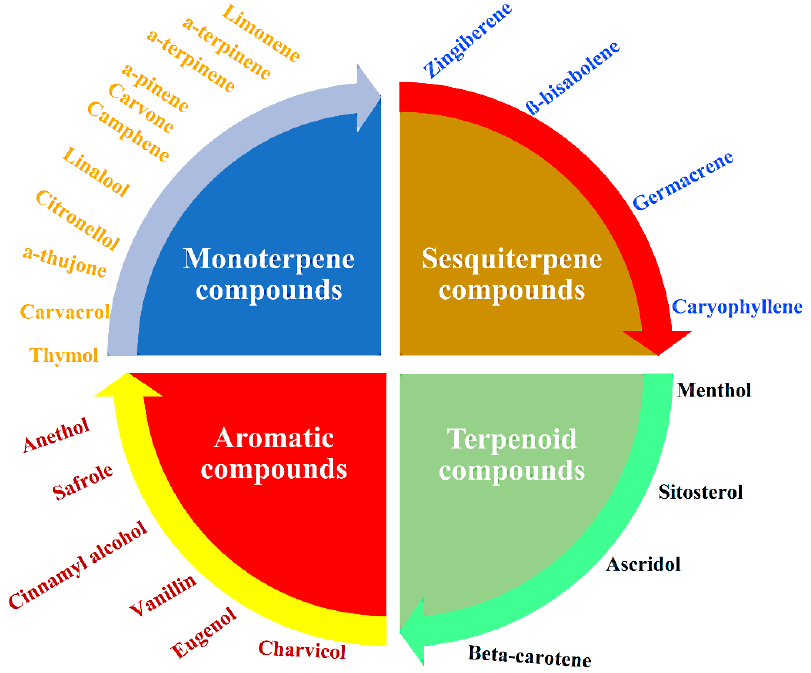
Figure 3. The main classes of EOs (monoterpenes, sesquiterpenes, terpenoids, and aromatic com- pounds), with some examples of their compounds [65,66].